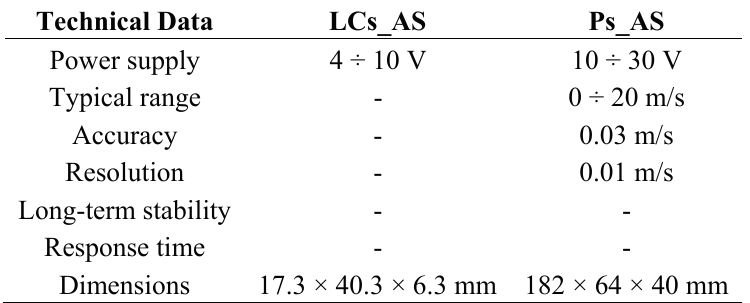
Table 6. Technical specifications sensors used to measure air